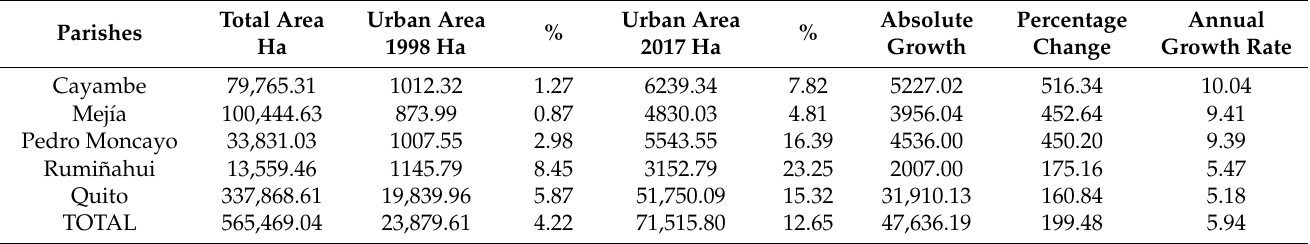
Table 2. Evolution of the urban area and annual growth rate of the cantons would comprise the new metropolitan area proposed to Quito 1998–2017.